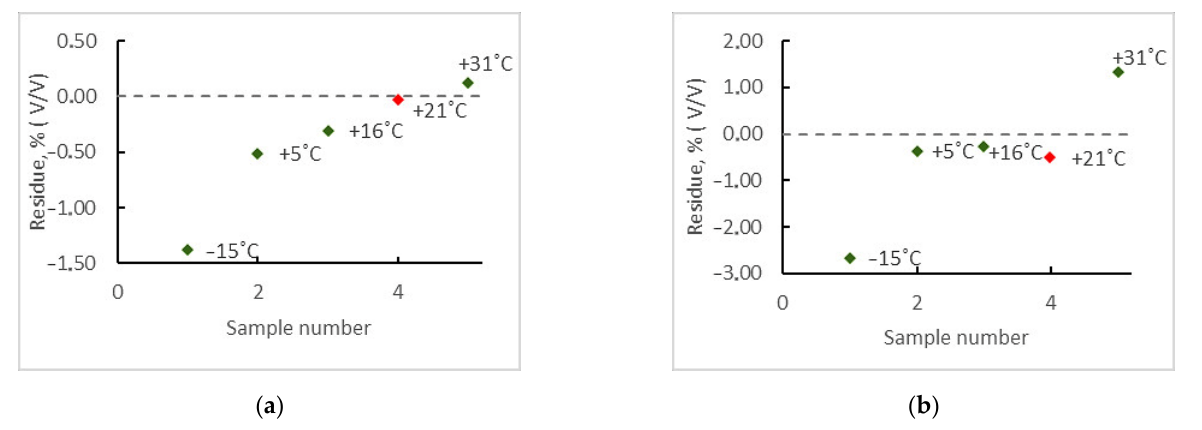
Figure 3. The prediction error percentage when the sample temperature deviates from the calibration temperature for: ( a )—the calibrated FAME quantification PLS model, ( b )—the calibrated HVO quantification PLS model.